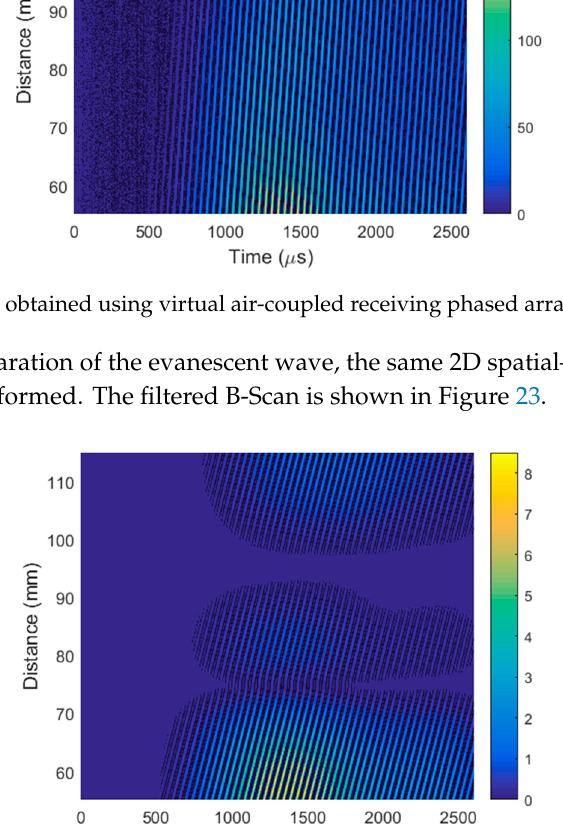
Figure 23. B-scan obtained by virtual air-coupled receiving phased array after 2D filtering.